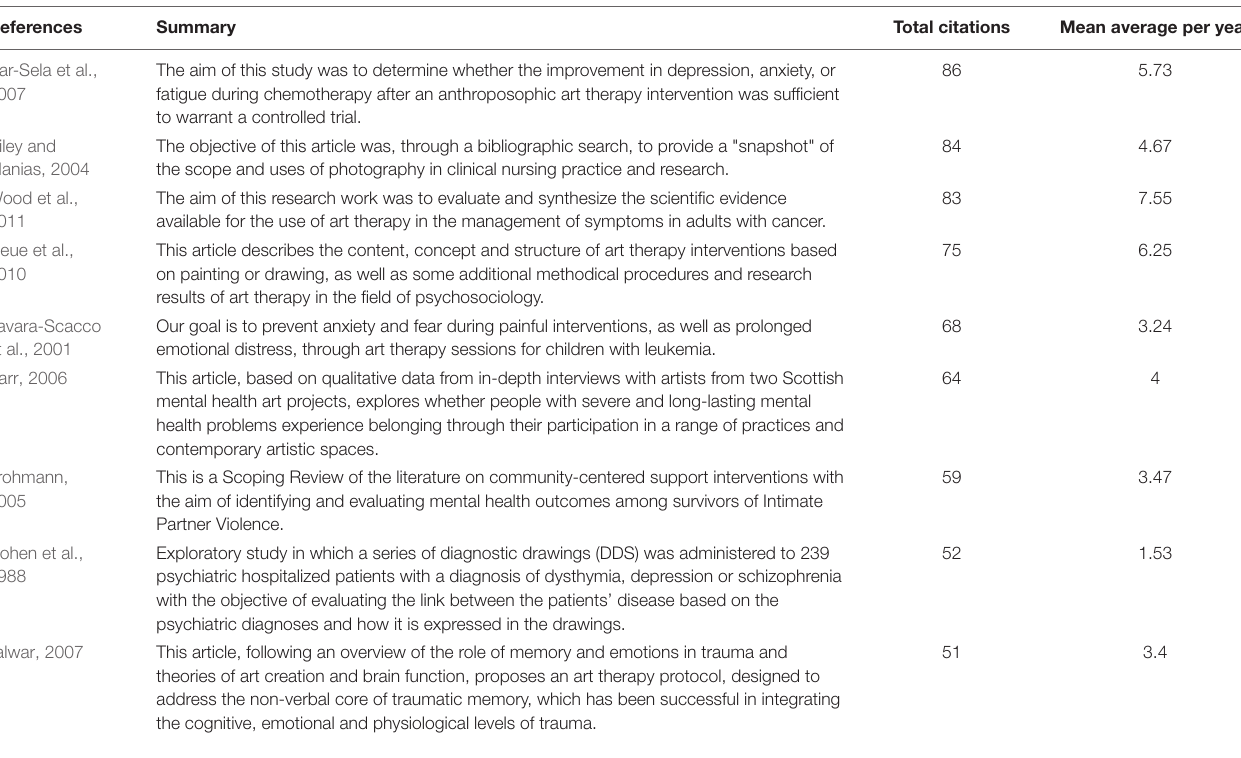
TABLE 5 | Reference of authors, topics covered, and citation of articles related to art